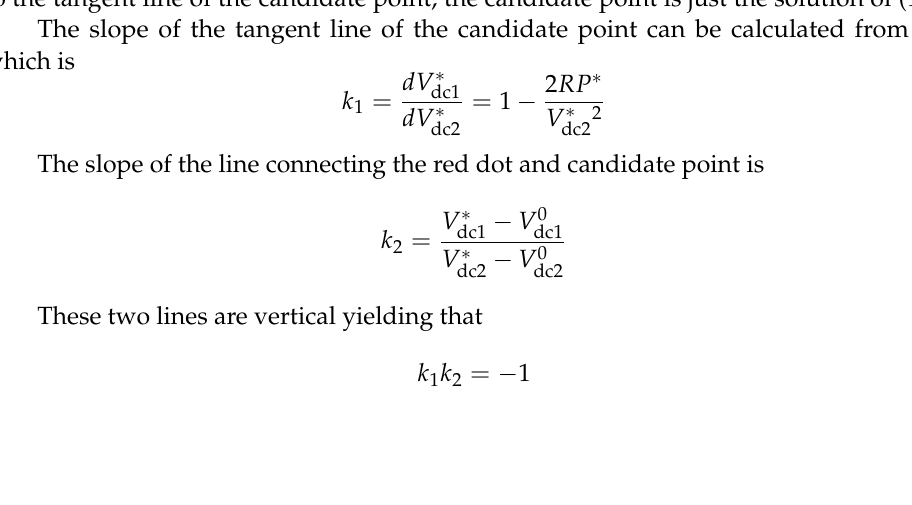
Figure 4. The process of solving (14). The red dot represents the initial state, the physics meaning of (14) is to find a candi- date point on the blue line in the green area whose distance from the red dot is shortest. Obviously, when the line connecting the red dot and the candidate point is perpendicular to the tangent line of the candidate point, the candidate point is just the solution of (14).